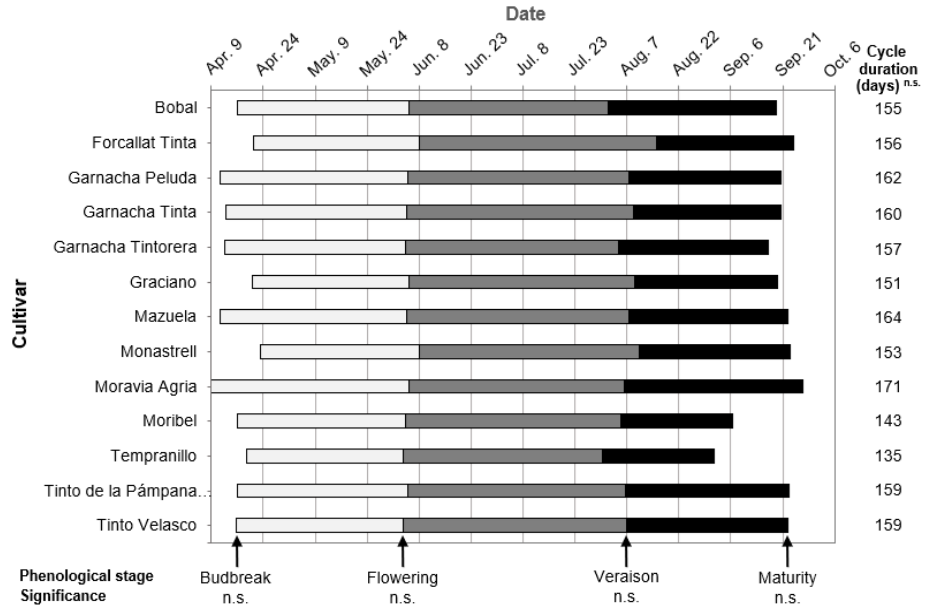
Figure 2. Duration and date of each phenological stage of the cycle of the different cultivars. Bars are 3-year averages. Different colored bars indicate the duration of each period between phenological stages. ANOVA; n.s., not significant.